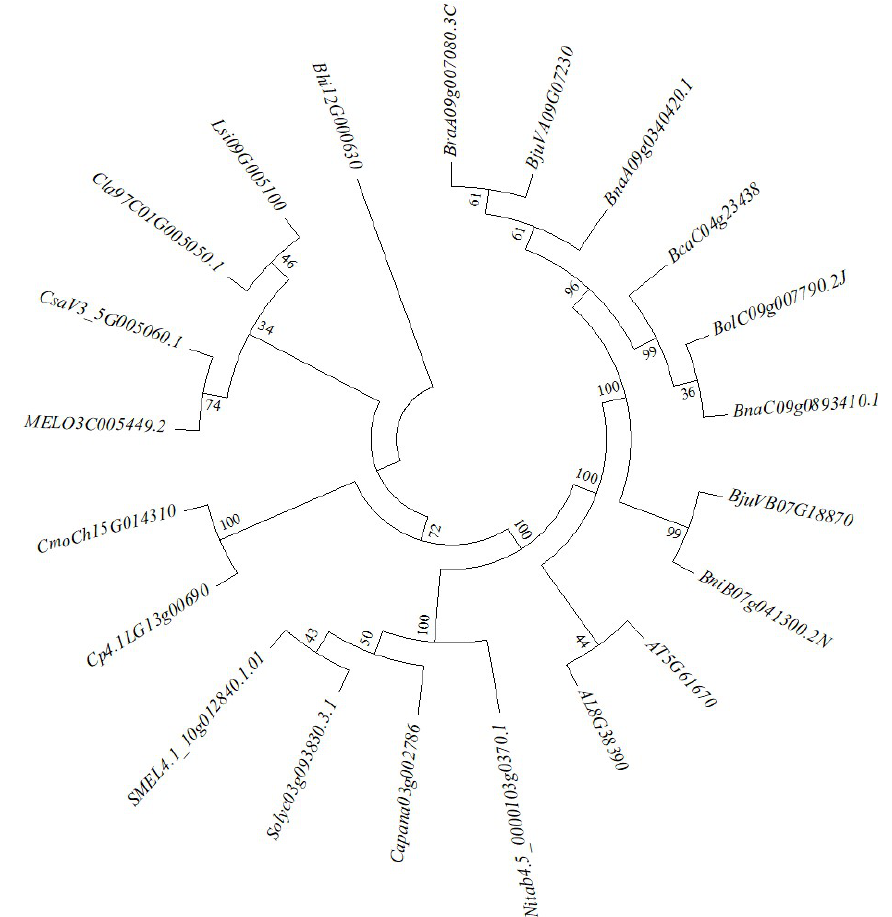
Figure 6. Phylogenetic analysis of ORANGE in Cruciferae and other species. The phylogenetic tree was constructed in MEGA 7.0 software (Mega Limited, Auckland, New Zealand) using the neighbor − joining method. The bootstrap replication values were determined from 1000 replicates.